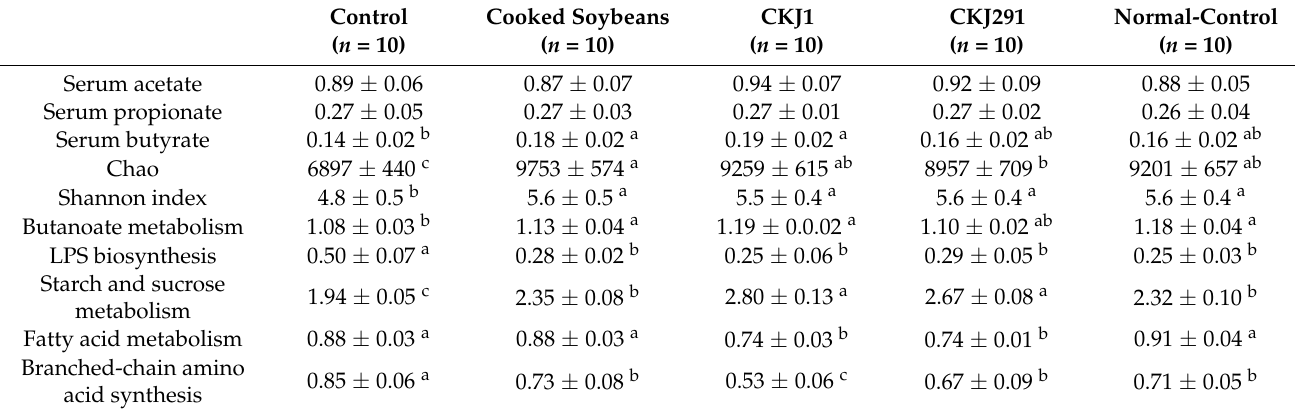
Table 6. Serum short-chain fatty acid concentrations and fecal bacteria metabolism on the 21st day after artery